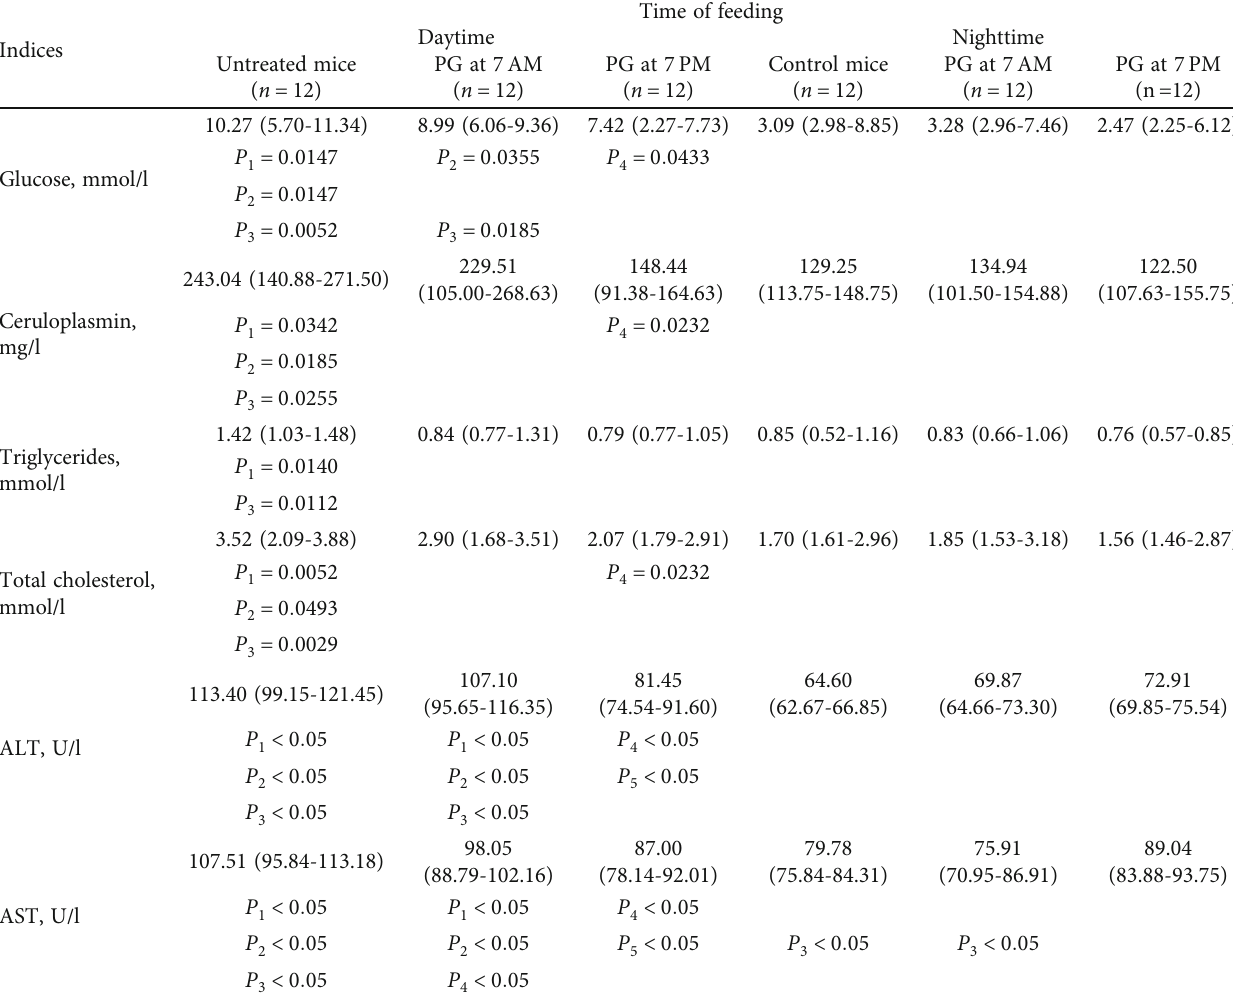
Time of feeding